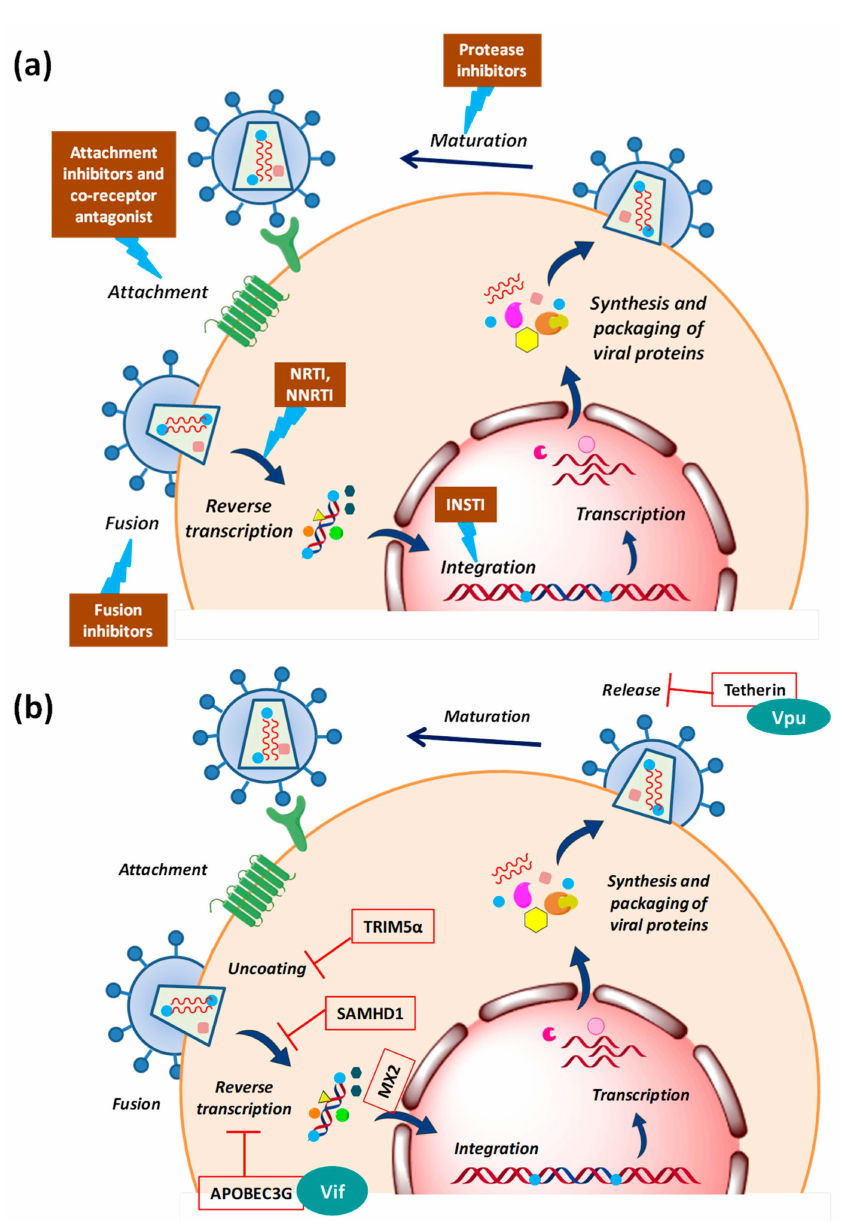
Figure 2. Diagrammatic representation of the sites of action of ( a ) clinical inhibitors of HIV-1 (ART) and ( b ) host restriction factors which are counteracted by HIV-1 accessory